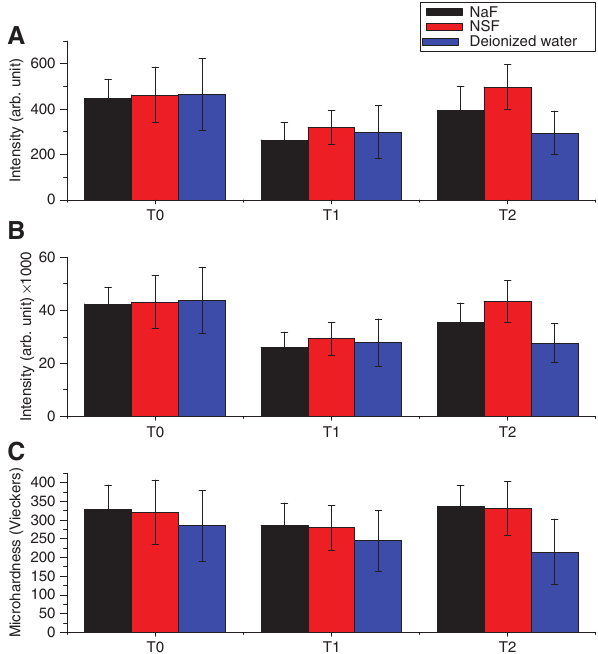
Figure 3: Fluorescence spectroscopy in (A) intensity peak, (B) total intensity (in arbitrary units) and (C) microhardness measurements (in Vickers hardness) obtained from dental enamel at T0 (before pH cycling), T1 (post-caries induction) and T2 (post-enamel treatment with NaF, NSF and deionized